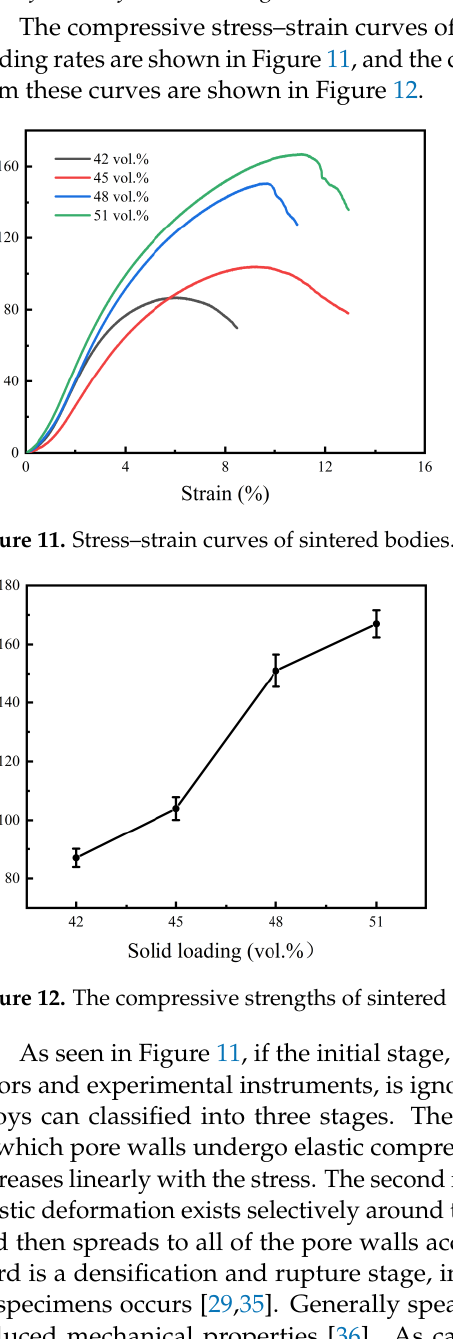
Figure 10. XRD patterns of ( a ) Ni-Ti blended powders and ( b ) NiTi alloy.